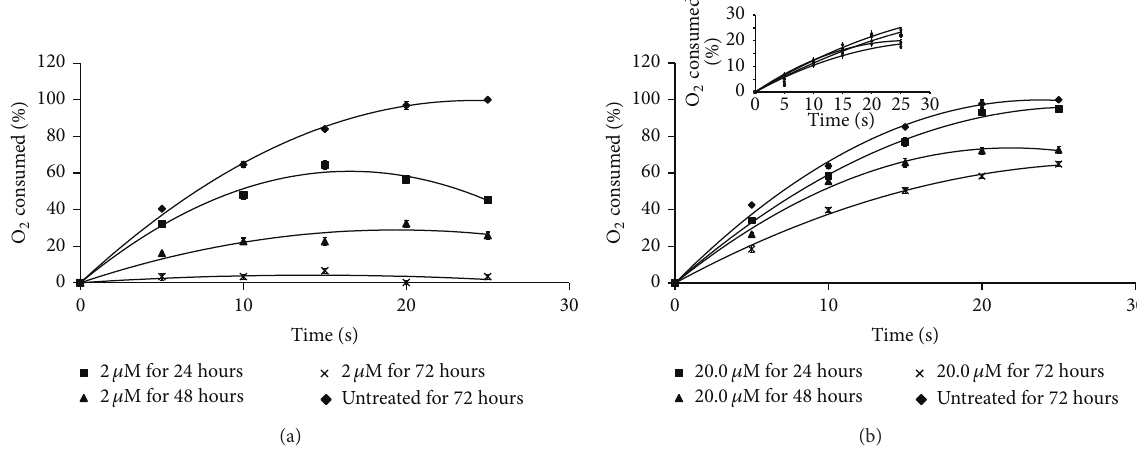
Figure 2: Impairment of oxygen consumption by As-NPs and As (III) treated Leishmania promastigotes. (a) The oxygen consumption by Leishmania promastigotes treated with 2 𝜇 M As-NPs for 24 ( ◼ ), 48 ( 󳵳 ), and 72 ( × ) hours and those left untreated for 72 hours ( X ) was measured by Gilson oxygraph as mentioned in Section 2. 1 × 10 6 promastigotes were taken into the oxygraph cell and oxygen consumption was measured for 25 seconds. The average values for each set from three independent experiments were expressed as percent of the total oxygen dissolved. The data for the samples that were left untreated for 24 and 48 hours were the same as those of sample of 72 hours (not shown). (b) The oxygen consumption by Leishmania promastigotes treated with 20.0 𝜇 M As (III) for 24 ( ◼ ), 48 ( 󳵳 ), and 72 ( × ) hours and those left untreated for 72 hours ( X ) was measured by Gilson oxygraph as mentioned above. The percentage of oxygen consumed by these cells was graphically presented as done in panel (a) above. The “inset” shows the oxygen consumption by the parasites treated with 2.0 𝜇 M As (III) for the same time periods. The error bars indicate standard deviations in each data point in triplicate sets ( 𝑛 = 3 ) of experiments. The 𝑃 values for each data point were calculated and found to be statistically significant ( < 0.05) (Table